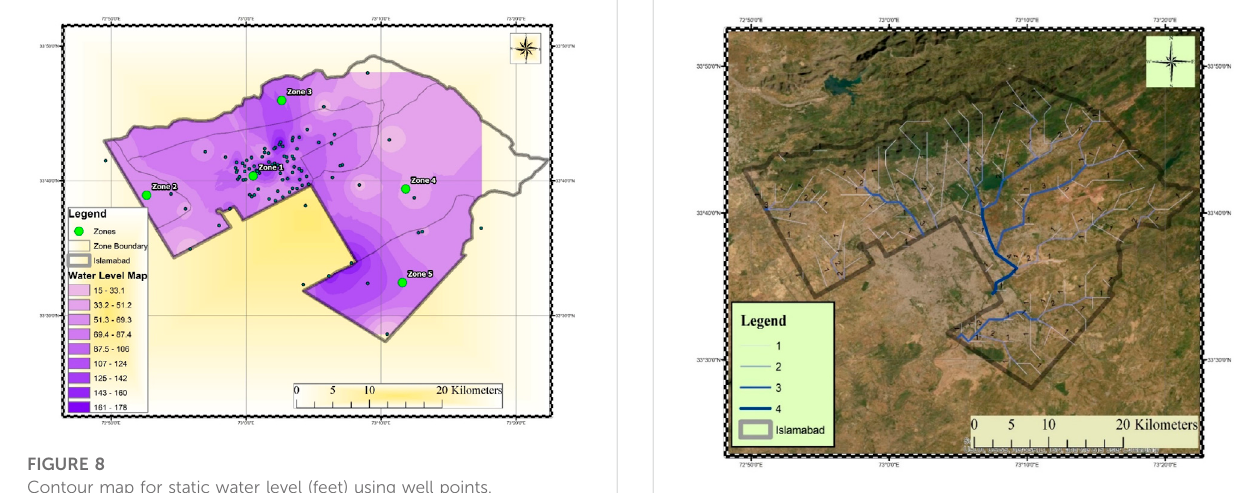
FIGURE 9 Stream pattern map of Islamabad (Legend: 1. Small streams; 2.